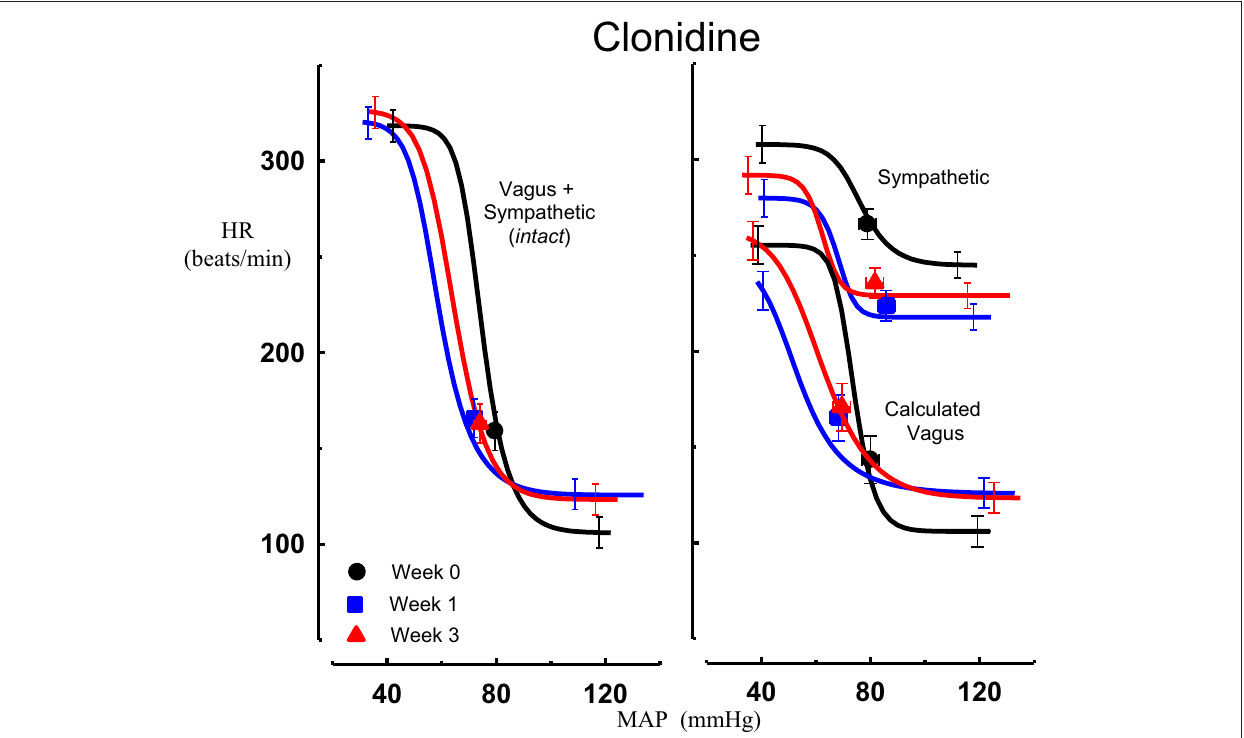
FIGURE 3 | Average sigmoid curves indicating the relationship between mean arterial pressure (MAP, mmHg) and heart rate (HR, beats/min) for the intact baroreflex curves (left panel) and the sympathetic and calculated vagal baroreflex curves (right panel) in seven conscious rabbits before (weeks 0, black line, black circles on all panels) and at weeks 1 (blue line, blue square on all panels) and 3 (red line, red triangle on all panels) of clonidine treatment. Symbols on curves represent resting values. Error bars are average SEM indicating variation between animals calculated from the ANOVA.